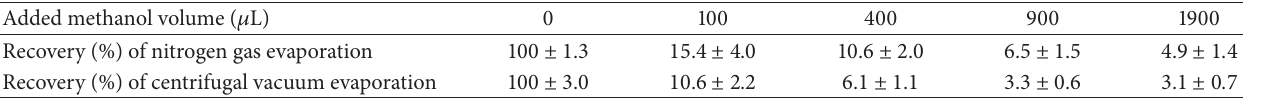
Table 5: The quantitation results of concentrated propofol standards with two different kinds of